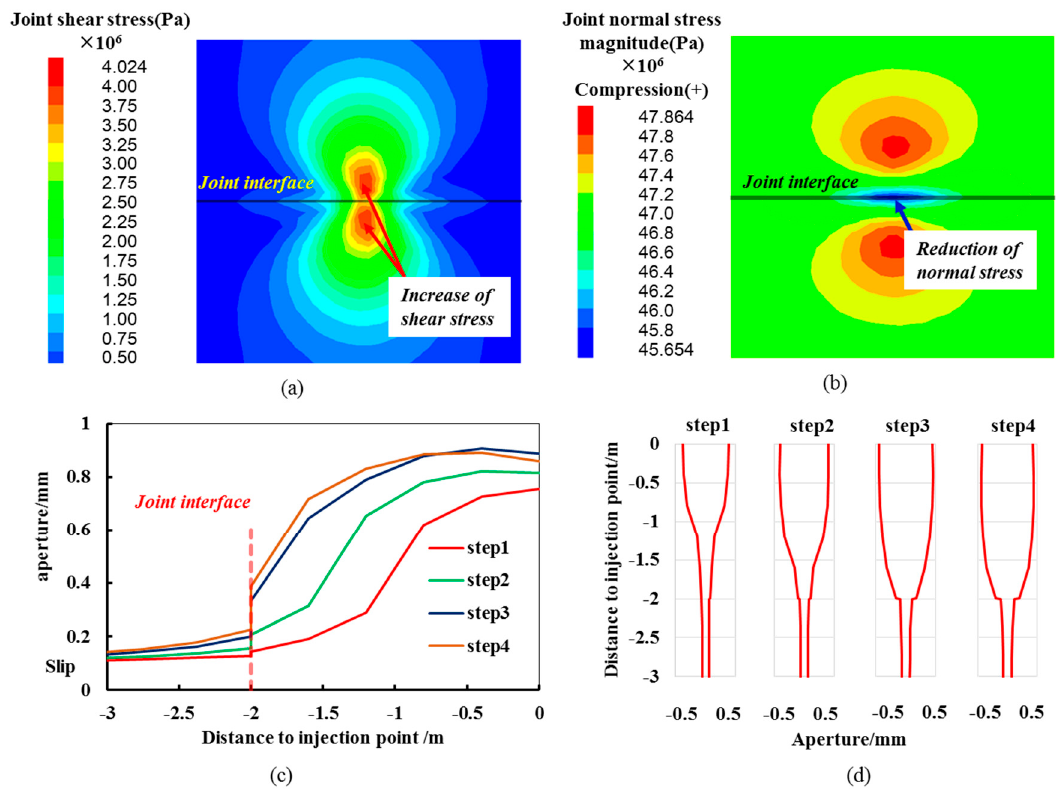
Figure 5. Results of numerical simulation: ( a ) shear stress on horizontal joint; ( b ) normal stress on horizontal joint; ( c ) aperture curves along vertical line passing through center point of vertical joint; ( d ) geometries of fractures at different steps.